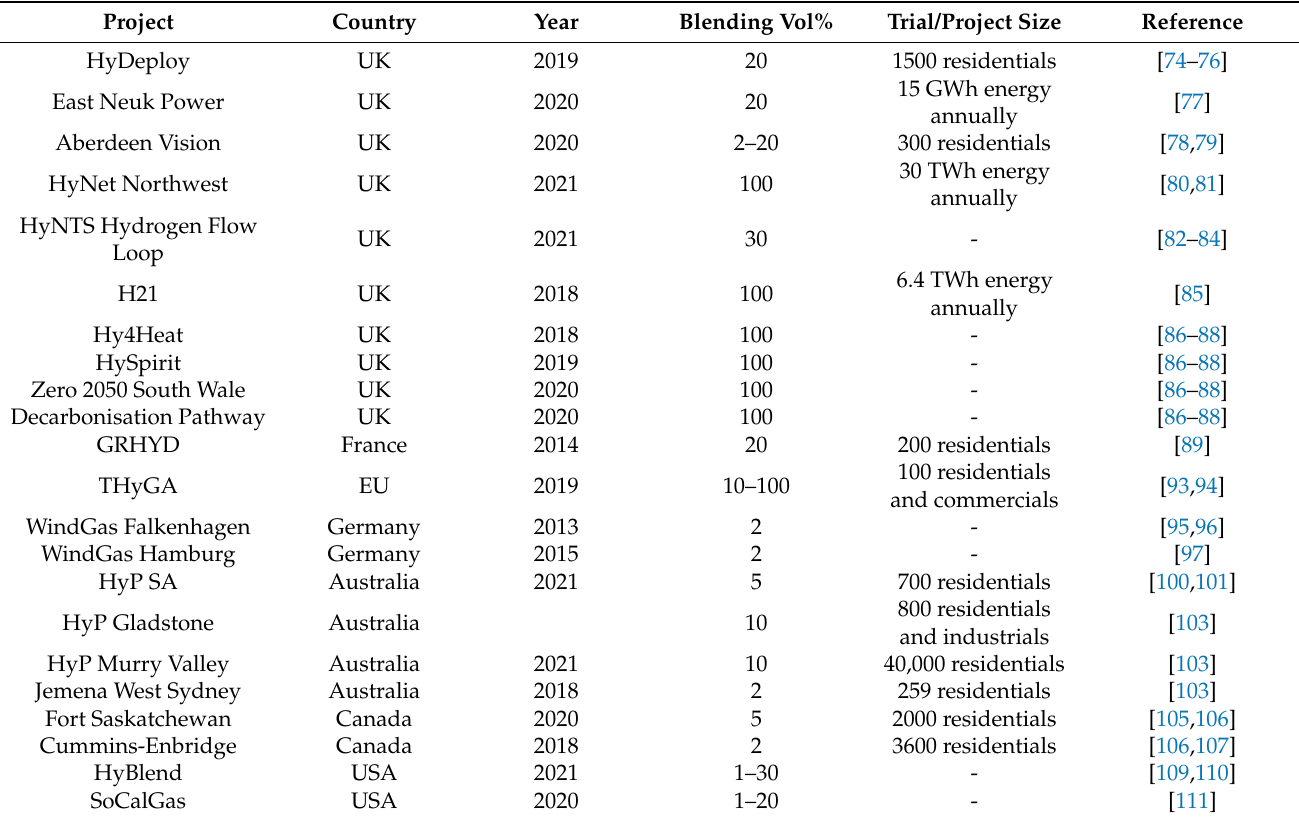
Table 2. World Hydrogen Blending Projects.